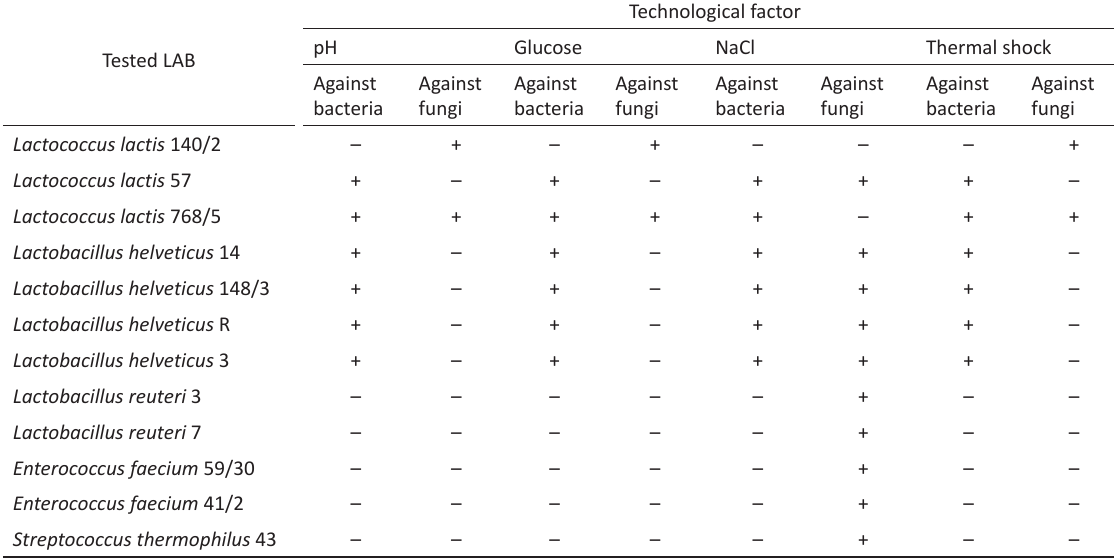
Table 5. Variety of tested LAB showing their abilities to be used as high antimicrobial activity retaining starter cultures during treatment under the effect of specific technological factor